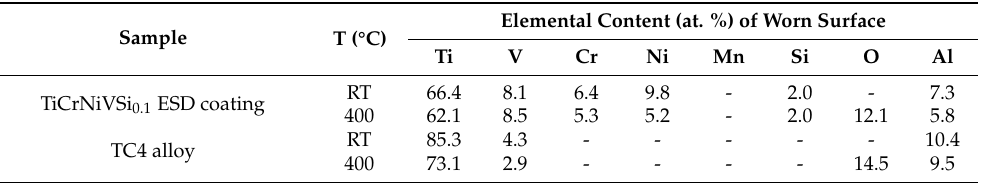
Table 6. EDS results of the typical region of worn surface of TC4 alloy and TiCrNiVSi 0.1 ESD coating samples after wear tests at room temperature and 400 °C.